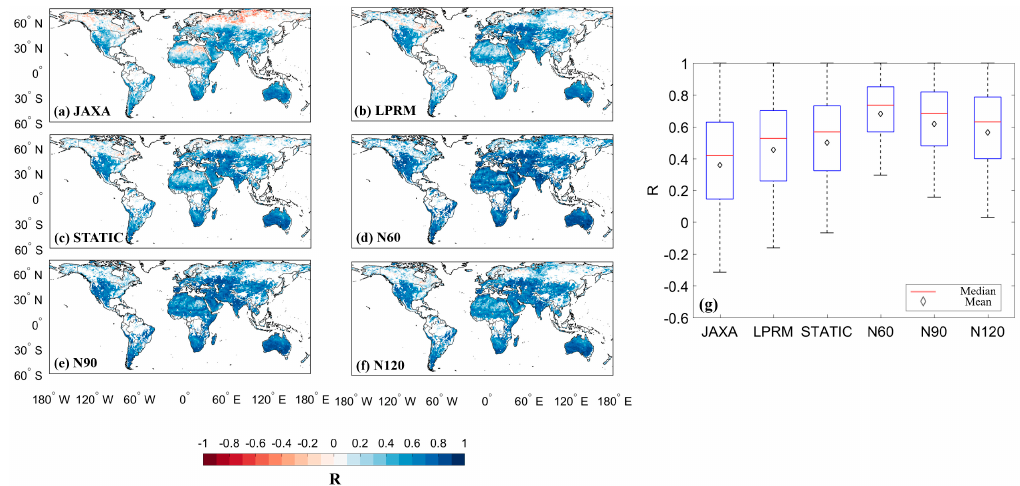
Figure 3. Results from experiments that uses ERA-Interim as the reference for various window sizes, N60, N90 and N120. Each panel shows the R between the reference and ( a ) JAXA; ( b ) LPRM; ( c ) static; ( d ) N60; ( e ) N90 and ( f ) N120; the more bluish colours in the maps indicate higher R against